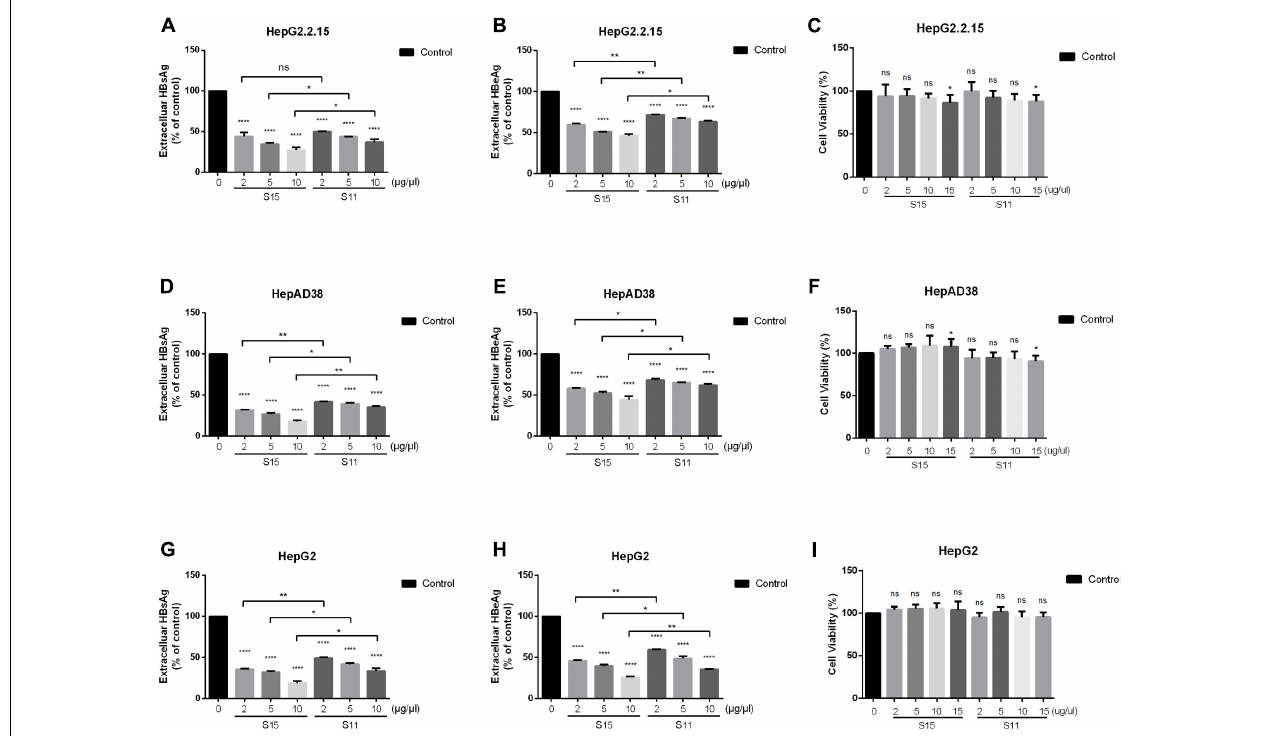
FIGURE 1 | Inhibitory effect of lettuce extracts on HBsAg and HBeAg expression in HepG2.2.15 cells, HpeAD38 cells and HepG2 cells transiently transfected with a replication-competent HBV clone. Cells were treated with two groups of lettuce extracts hydroponically cultured with different nitrogen source (S15 treated with 9 mM glycine and S11 with the same concentration of nitrate) at the indicated concentrations for 2 days. Dose-dependent suppression of HBV antigen expression by lettuce extract in different HBV cell lines (A,B,D,E) and HepG2 cells transiently transfected with HBV (G,H) . HBsAg and HBeAg were quantified using an electrochemical illuminescent immunoassay. The CCK8 assay was used to determine the cytotoxic effect of lettuce extracts in different cell lines (C,F,I) . All values are expressed as percentages relative to untreated control (Control). Statistical significance was calculated using student’s t -test. Ns, not significant, ∗ P <